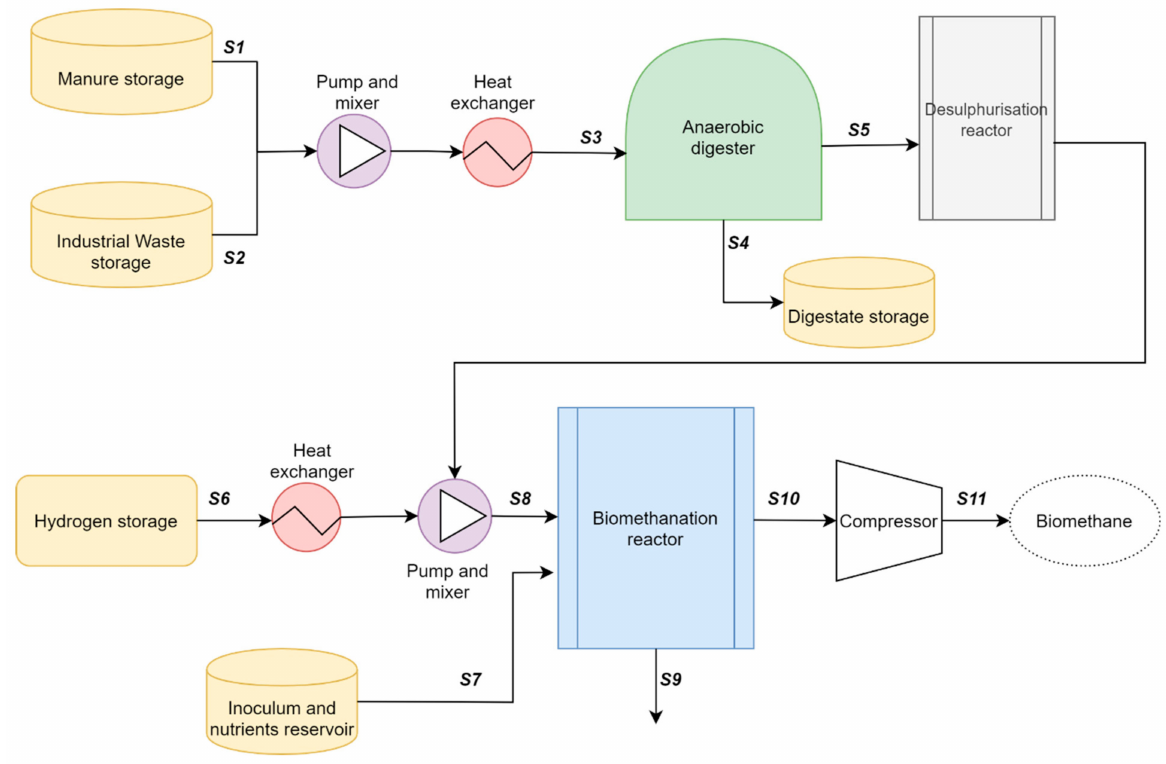
Figure 1. Process flowsheet of the anaerobic digestion and biomethanation